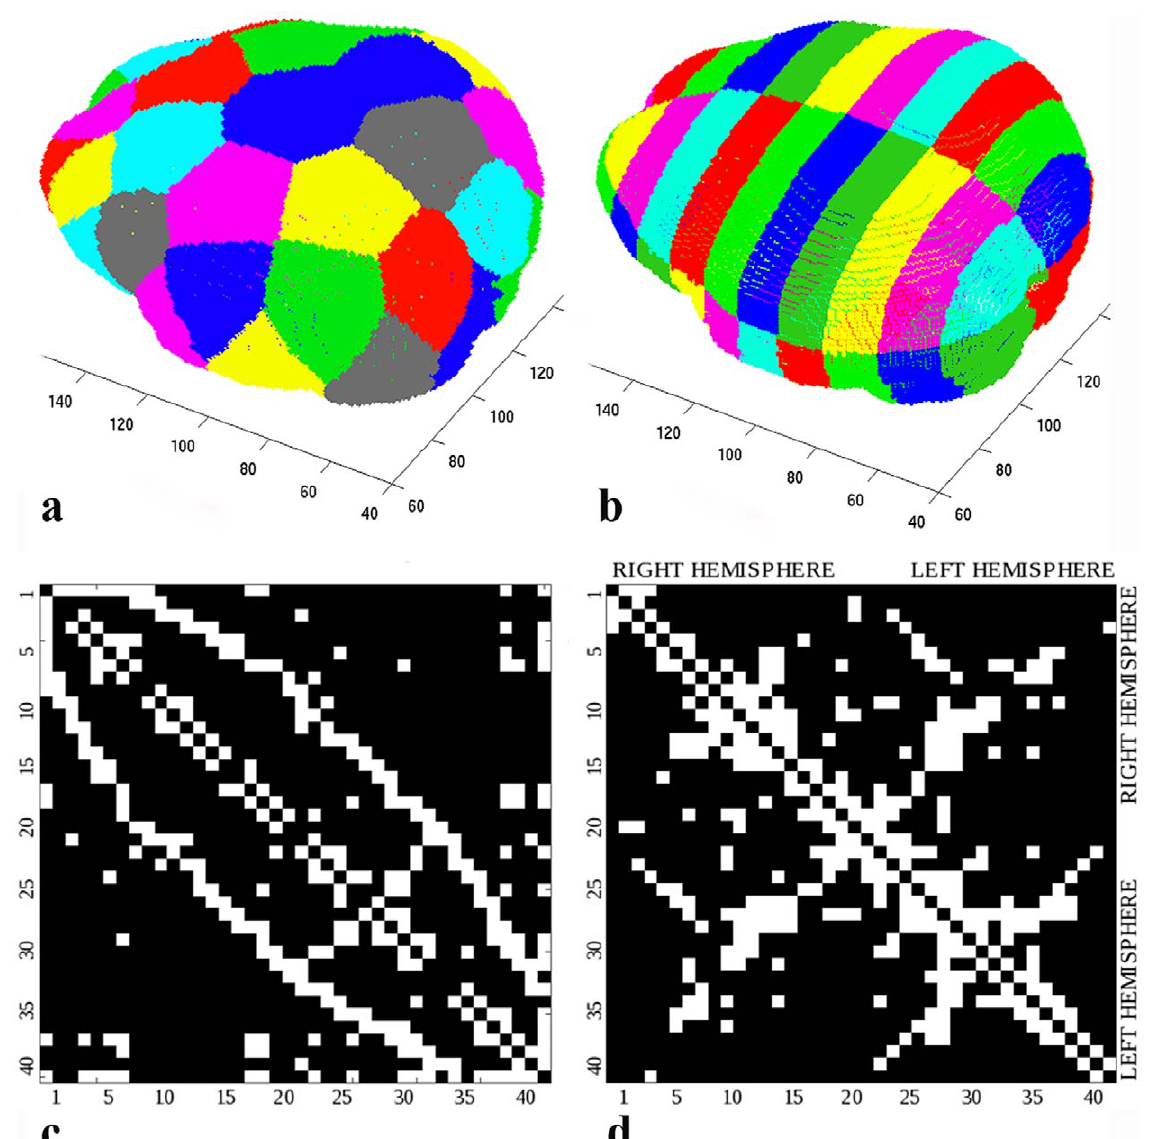
Figure 2. Parcellation Schemes and Adjacency Matrices. a) Equipartition and b) gridded parcellation of the six-month old baby brain. c), d) Adjacency matrices binarized with threshold 1 for both parcellation schemes in a representative baby with NMS 0, for which no diffusion directions were discarded.